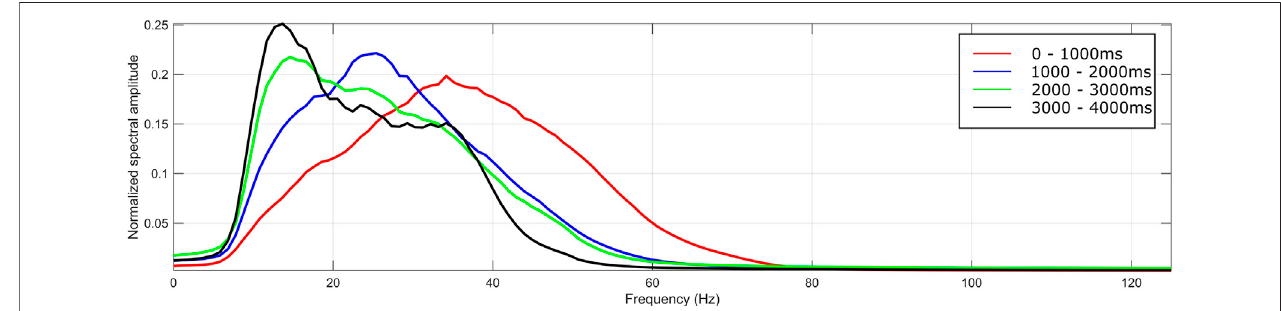
FIGURE 10 | A) A simple comparison of the frequency content of the Bowland-12 3D seismic re fl ection survey for different time intervals. The frequency content decreases with depth.